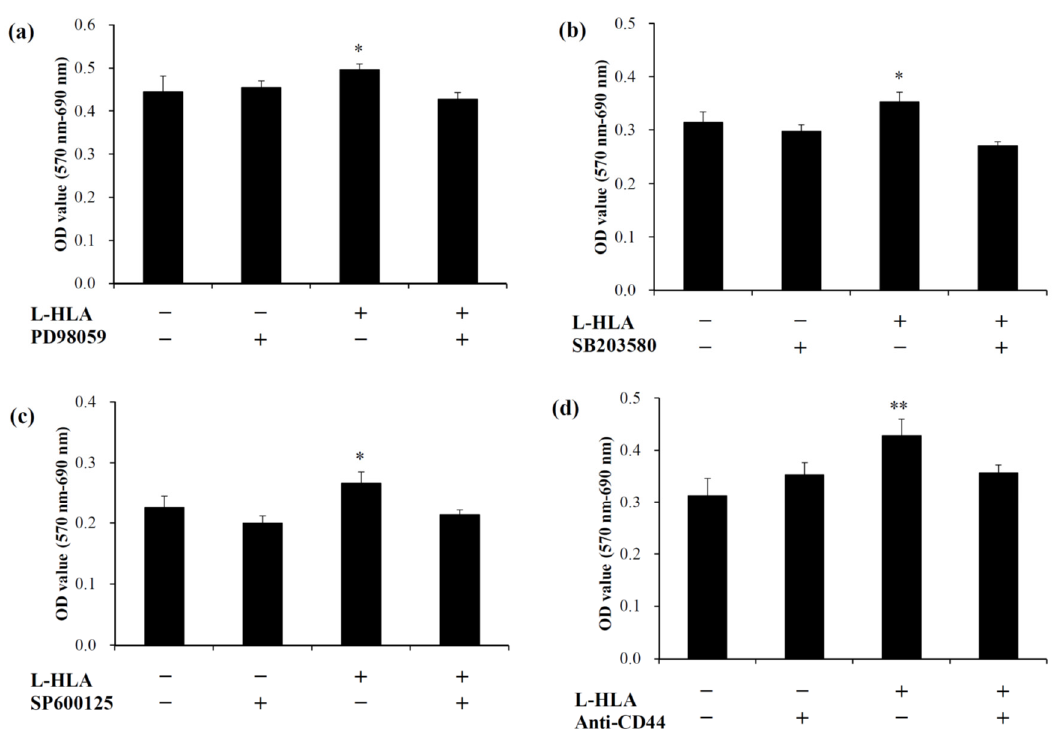
Figure 5. Growth of DPSCs cultured with L-HLA. L-HLA promoted DPSC growth; however, MAPK inhibitors such as ( a ) ERK inhibitor PD98059, ( b ) p38 inhibitor SB203580, ( c ) JNK inhibitor (SP600125) caused significantly lower viability when compared to cells treated without an inhibitor. The similar inhibited effect was found when the cells were treated with anti-CD44 (d). Significance is indicated as * ( p < 0.05) and ** ( p < 0.01).